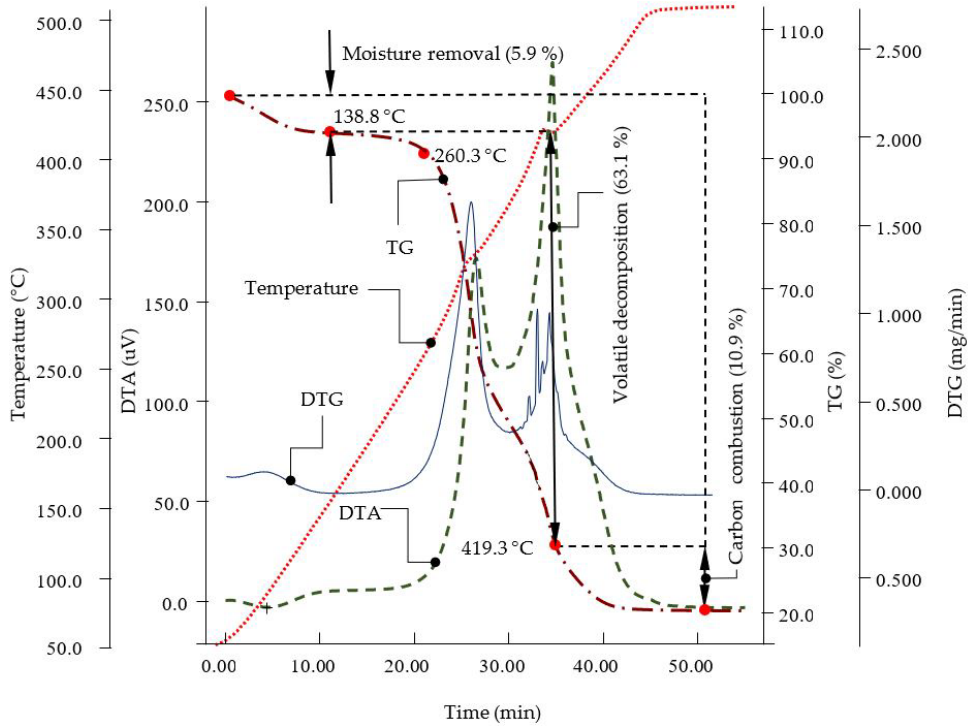
Figure 5. Thermogravimetric analysis of the rice husk sample (Red dotted: Temperature; Blue dotted: DTG; Green dashed: DTA; Red dashed: TG).